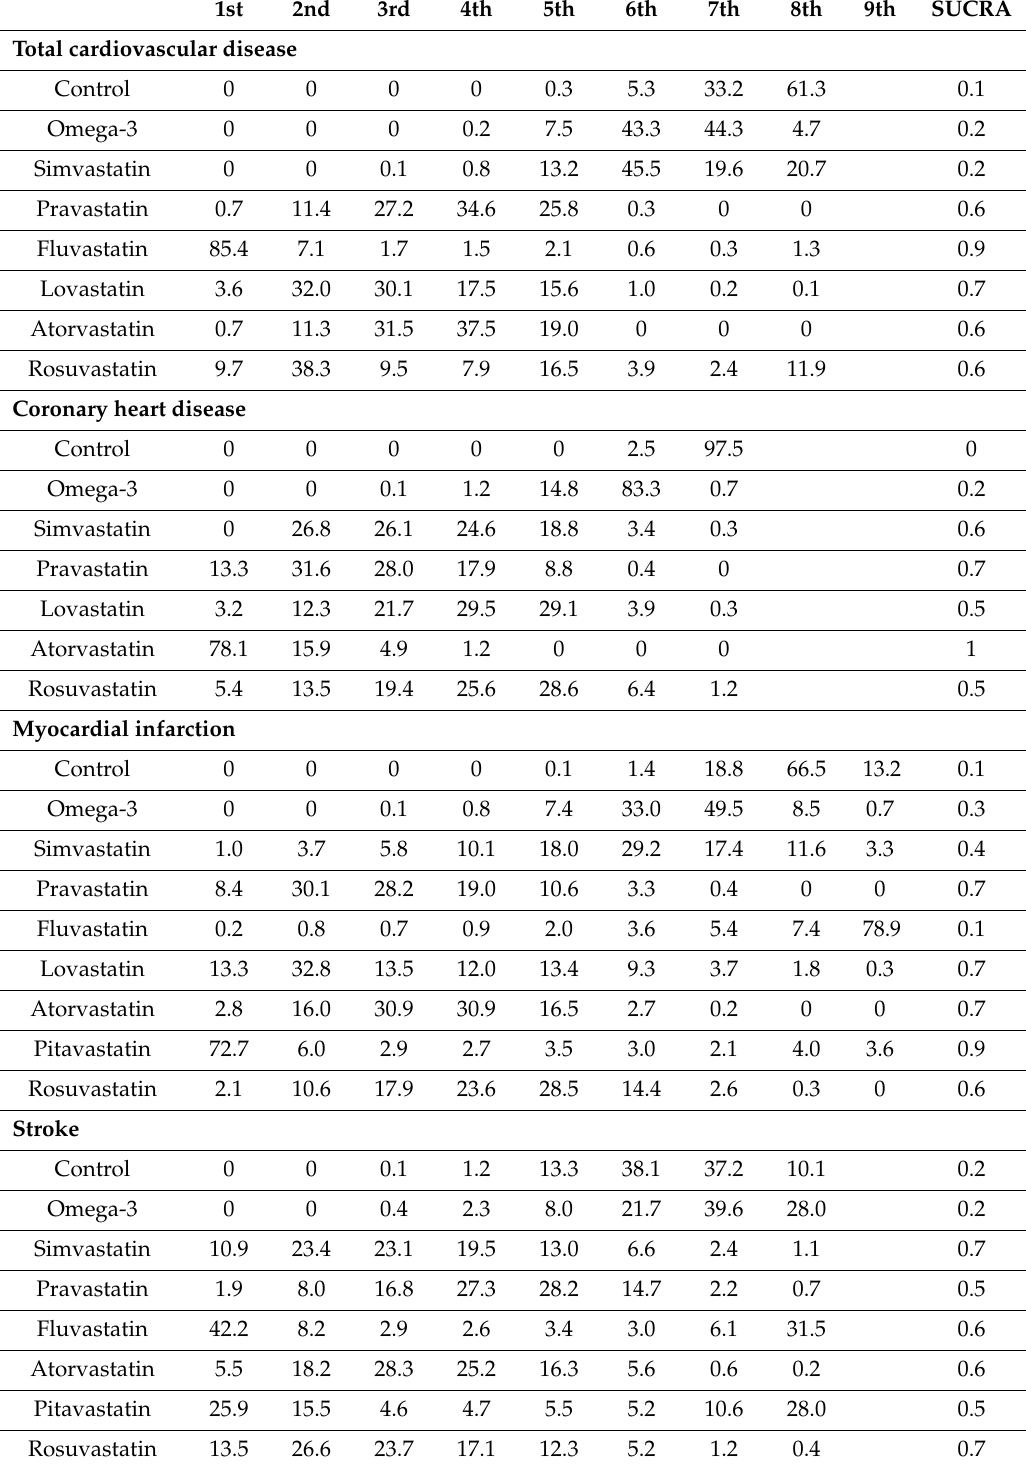
Table 5. Ranking probabilities and surface under the cumulative ranking (SUCRA) values of treatments according to di ff erent